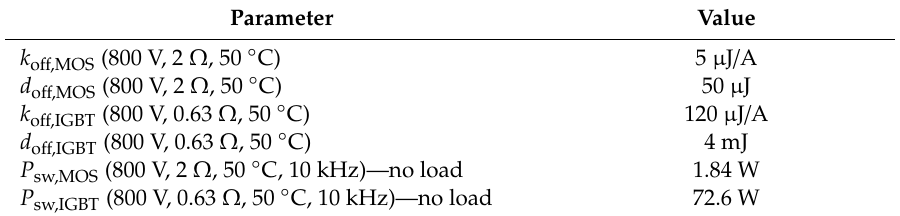
Table 5. Turn-o ff loss characteristics of FF600R12KE4 IGBT and IMZ120R030M1H SiC–MOSFET under consideration of no-load